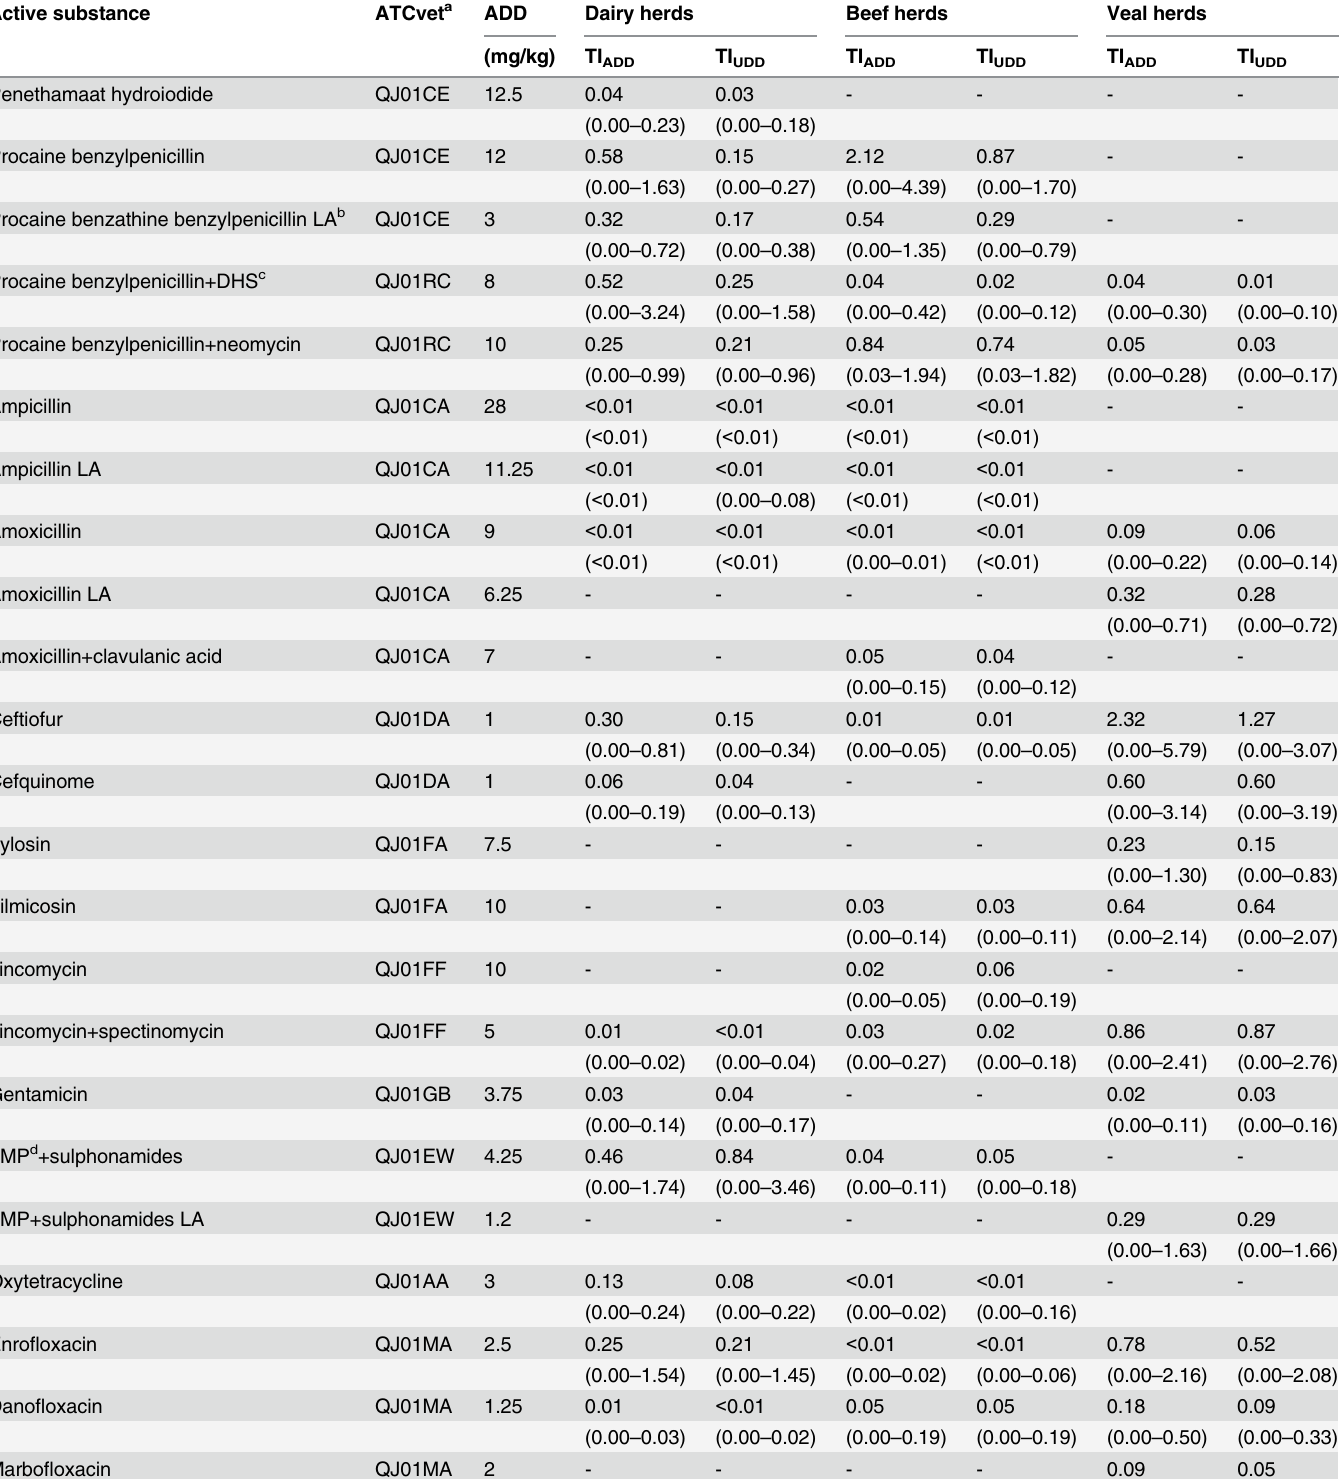
Table 3. Average treatment incidences (min-max) based on animal defined daily dose (ADD; TI ADD ) and used dose (UDD; TI PDD ) of the parenteral antimicrobial drugs in the three different herd